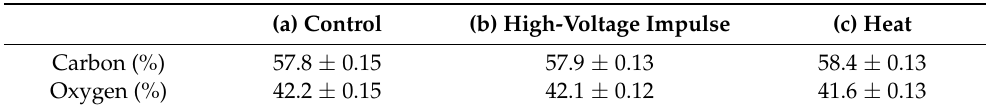
Figure 8. EDS spectrum of the body surface of D. gallinae killed using pulsed high voltage. ( a ) Control. ( b ) High-voltage impulse. ( c ) Heat. An EDS spectrum of the surface of the mite killed through high-voltage impulse revealed the presence of 58% carbon and 42% oxygen, with no discernible changes before and after the application of voltage. The images were taken at an incident voltage of 5.0 kV, a working distance of 16.2 mm, a magnification of × 1500 and in high vacuum mode. The Au components are shown in grey. Table 1. Body surface composition by EDS analysis. (a) Control. (b) High-voltage impulse. (c) Heat. All values are expressed as a percentage by